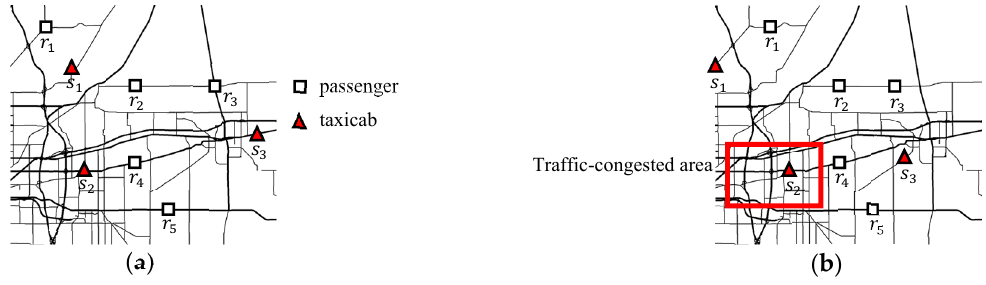
Figure 1. Example of dynamic road networks ( a ) traffic condition at time t 1 ; ( b ) traffic condition at time t 2 .